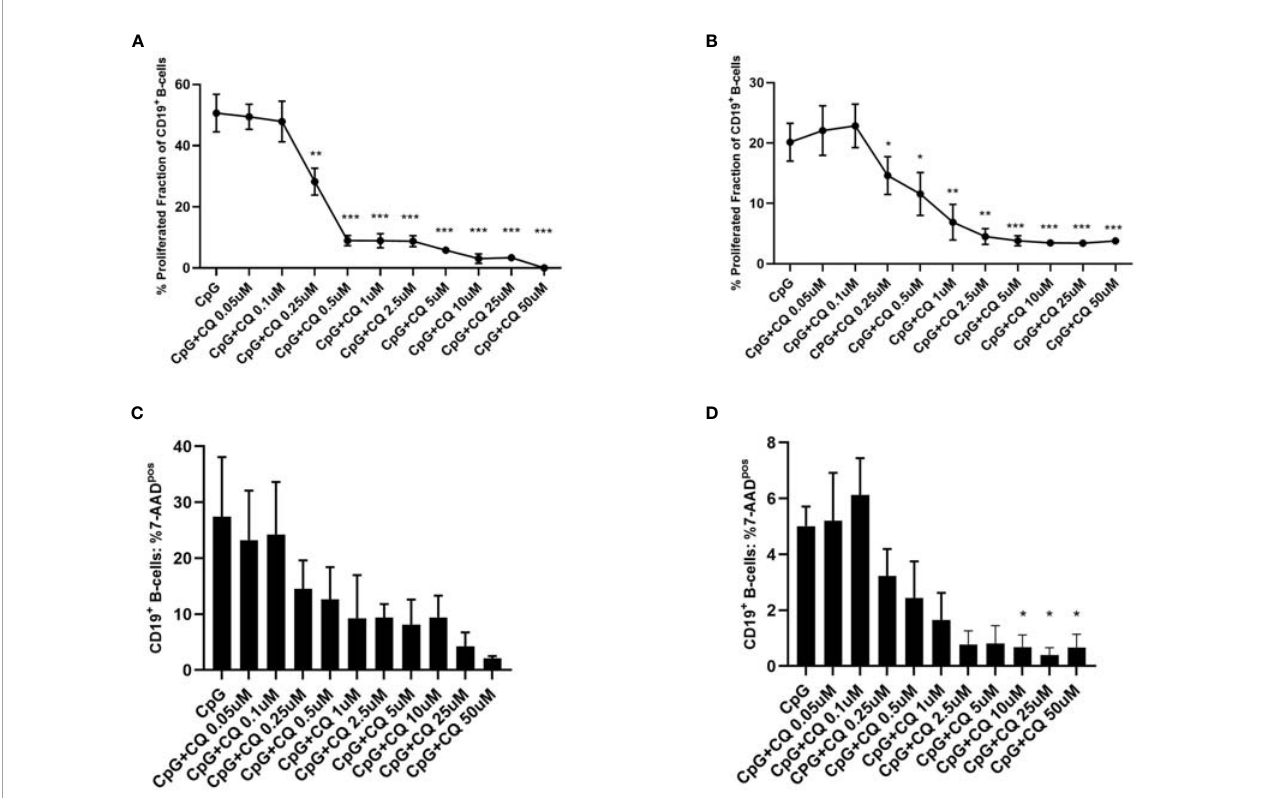
FIGURE 1 | Dose-dependent suppression of TLR9-induced B-cell proliferation by CQ. PBMCs or puri fi ed B-cells were labeled with CFSE and stimulated with CpG in presence of different concentrations of CQ. After 72 hours, CD19 + B-cell proliferation was determined by CFSE-dilution. (A) Impact of CQ on B cell proliferation with CpG stimulation in PBMCs. (B) Impact of CQ on B cell proliferation with CpG stimulation in puri fi ed B cells. (C) Impact of CQ on vitality of B-cells after stimulation with CpG in PBMCs. (D) Impact of CQ on vitality of B-cells after stimulation with CpG in puri fi ed B-cells, P-values were calculated by repeated-measures ANOVA and correction for multiple comparisons were done by Dunnett ’ s test. *p < 0.05, **p < 0.01, ***p < 0.0001 (against